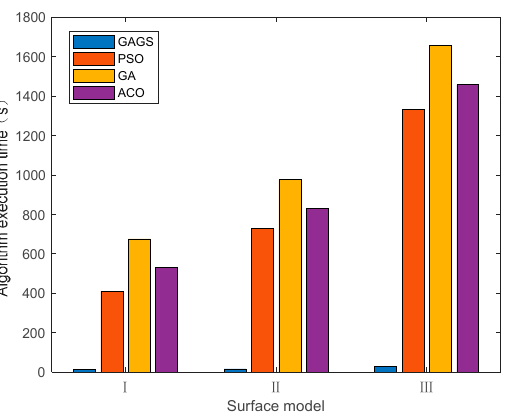
Figure 16. Comparison histogram of the execution time required for each algorithm to complete the deployment plan under different surface models.